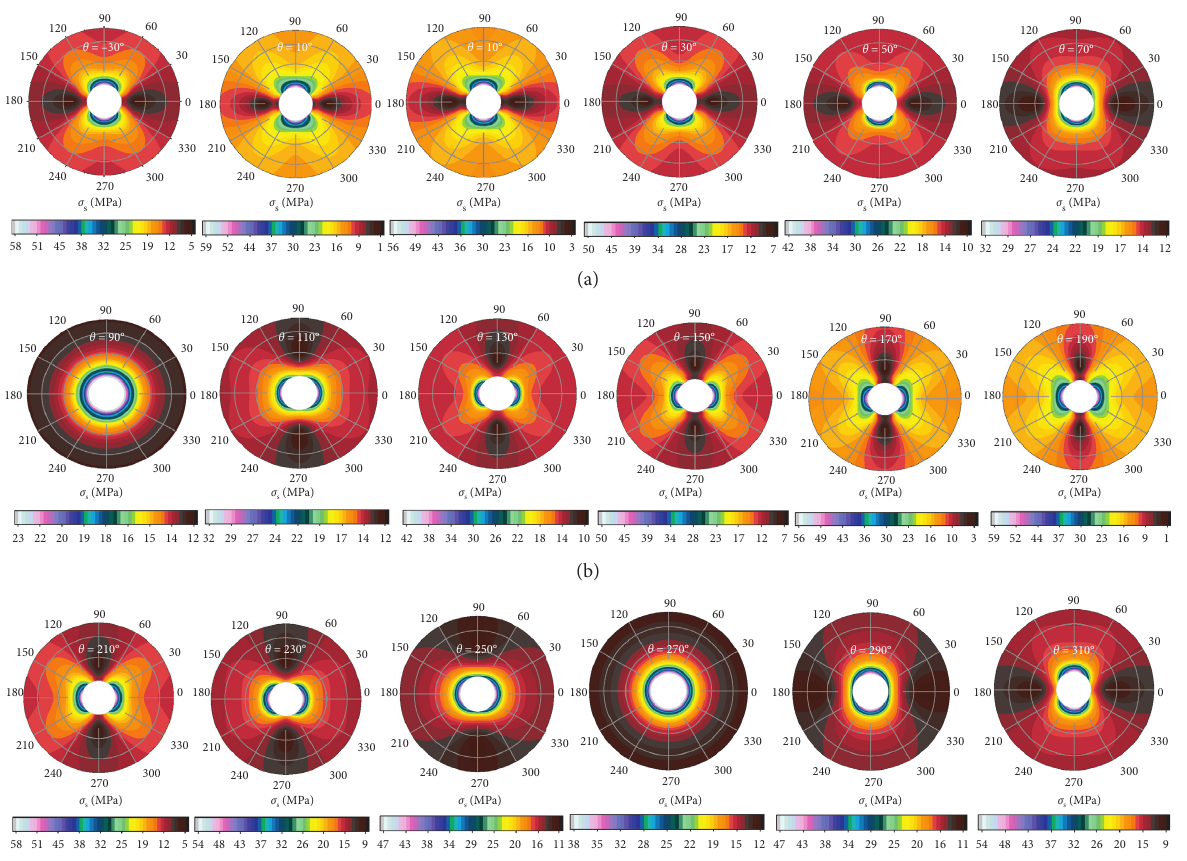
Figure 2: Distribution of principal stress difference of surrounding rock in different types of stress fields. (a) σ -type stress stress field. (c) σ h